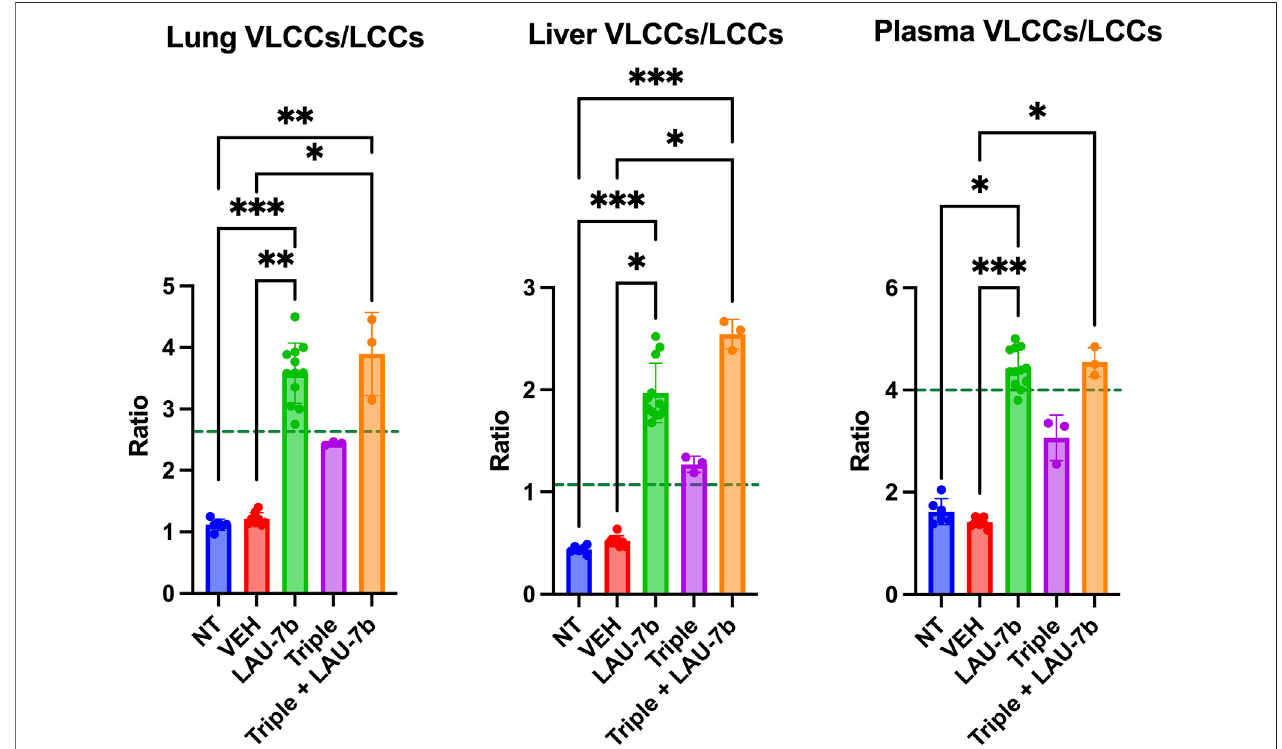
FIGURE 8 | Combination of Triple therapy and LAU-7b improves VLCCs/LCCs ratios in lungs, plasma and liver of F508del/F508del (DD) mice. Treatment of LAU- 7bimprovestheratioofVLCC/LCCinallsamplesofDDmicewhichishigherthanmeanlevelsseeninWTmice(dottedgreenline).Meanwhile,thesameeffectisnotseen in DD mice treated with Triple therapy alone. However, the combination of LAU-7b and Triple can restore and bring the VLCC/LCC ratio in lungs, plasma and liver of DD mice above the levels seen in WT mice ( n = 6, 8, 12, 3, 3, respectively for DD-NT, DD-VEH, DD-LAU-7b, DD-Triple, DD-Triple + LAU-7b). Kruskal – Wallis One-Way ANOVA with Dunn ’ s correction, where * p < 0.05, ** p < 0.01, *** p < 0.001, **** p <